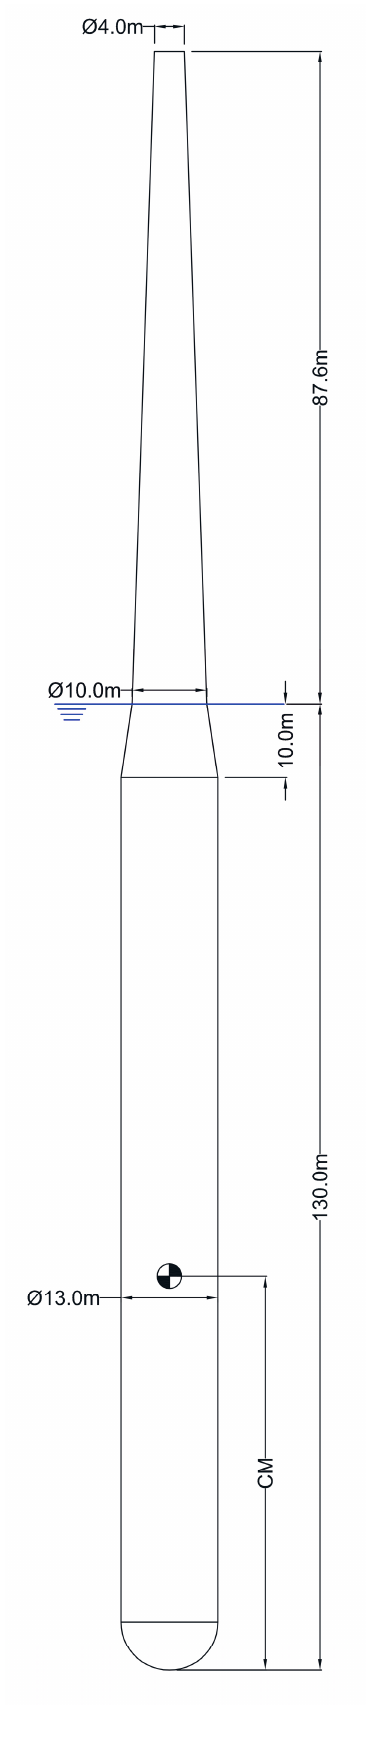
Figure 1. Sketch of Windcrete